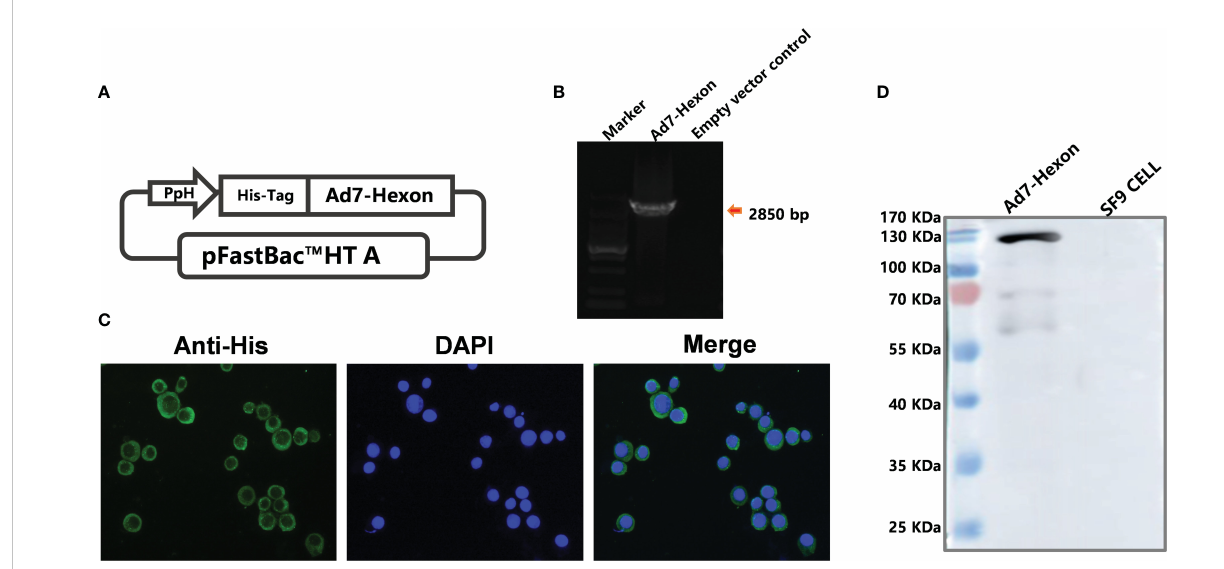
FIGURE 1 Construction of recombinant baculovirus carrying the Ad7-hexon gene and con fi rmation of the expressed adenovirus subunit vaccine type 7 rBV- hexon. (A) The adenovirus type 7 hexon gene was inserted into the pFastBac ™ HT A vector. (B) Insertion of the Adv7-hexon gene into the recombinant baculovirus was con fi rmed by PCR. (C) An indirect immuno fl uorescence assay was performed to detect the expression of hexon protein using His-labeled antibody. (D) The adenovirus type 7 hexon protein was detected by western blot. The arrow indicates a destination stripe of 2850bp